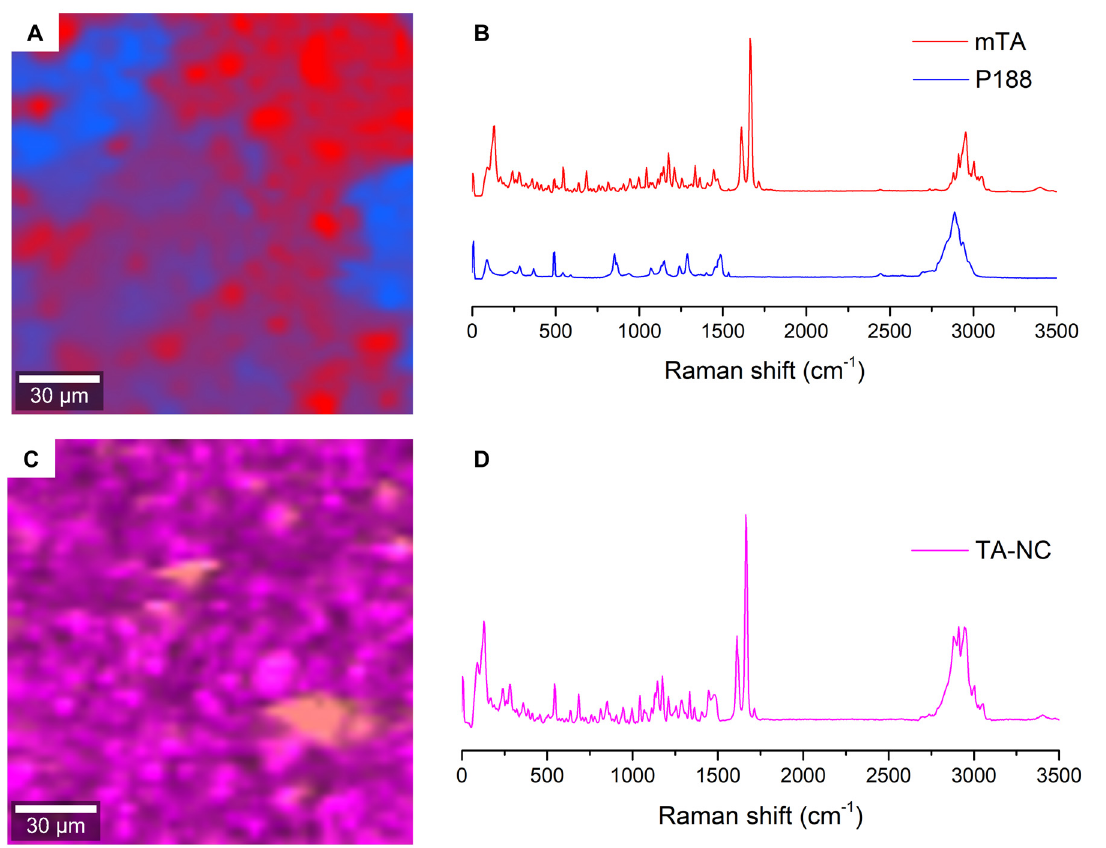
Figure 8. ( A ) Confocal Raman image for PM showing the distribution of the most relevant components (coinciding with mTA and P188) and ( B ) their corresponding averaged spectra according to their selected areas. ( C ) Confocal Raman image for TA-NC, showing a strong homogeneity, as evidenced in ( D ) the average Raman spectra.